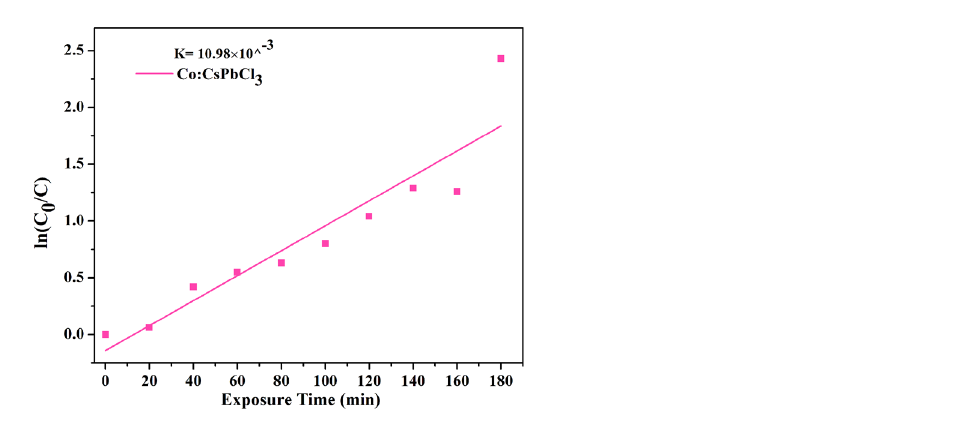
Figure 14. The slope of Co:CsPbCl 3